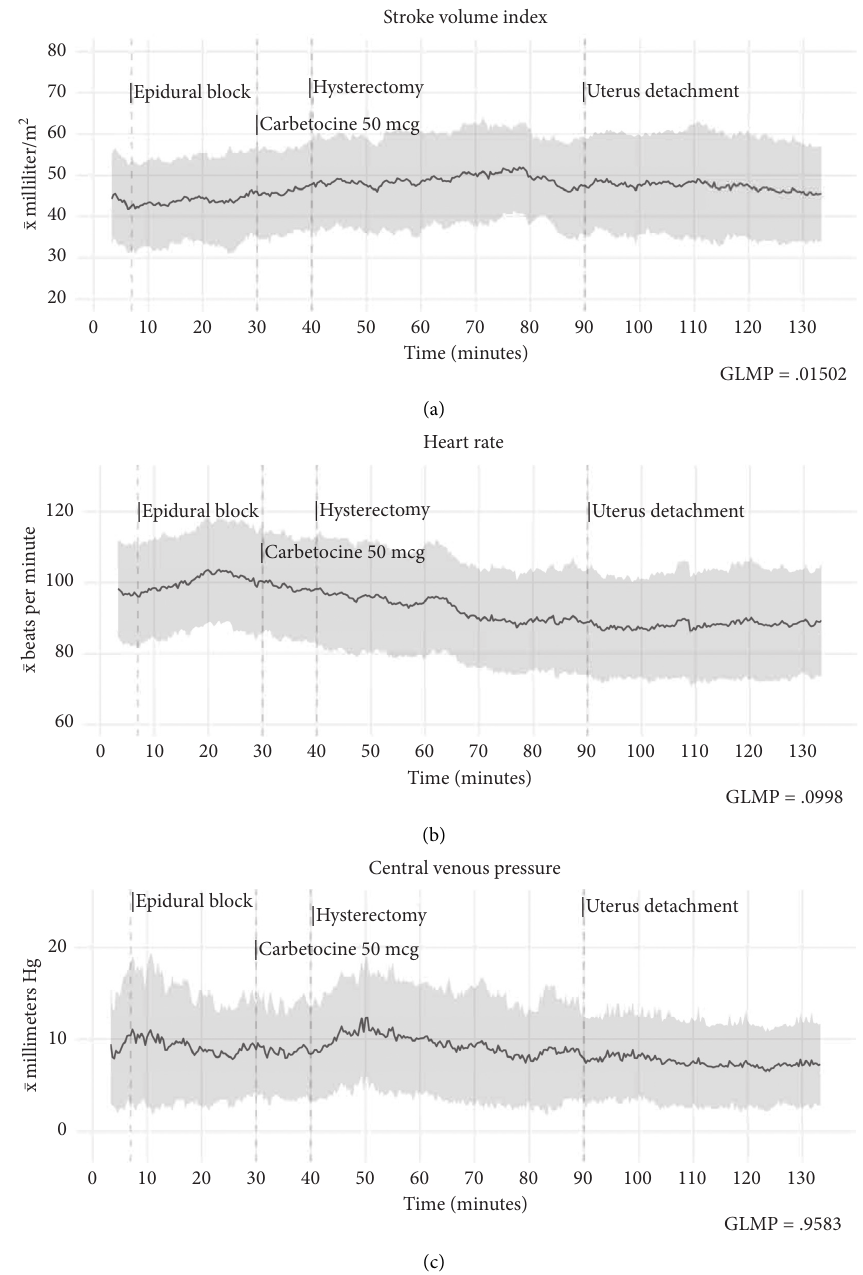
Figure 2: Hemodynamic trends (x ̄ , bold black line; σ , gray zone). (a) Increased variance ( P � 0 . 015) in the stroke volume index occurred within the measurements; the pattern could be explained by an increase in the variability between the individuals; however, these variances were more noticeable when the effect size (Cohen’s d) was measured after 60 and 75 min. The heart rate (b) was expected to change due to cardiac and vascular adaptations caused by the epidural block neurovegetative effects and featured mild variance throughout the surgery. Central venous pressure (c) showed minor variations during the procedure. Initial increments correspond to the patients’ lateral decubitus position for the epidural